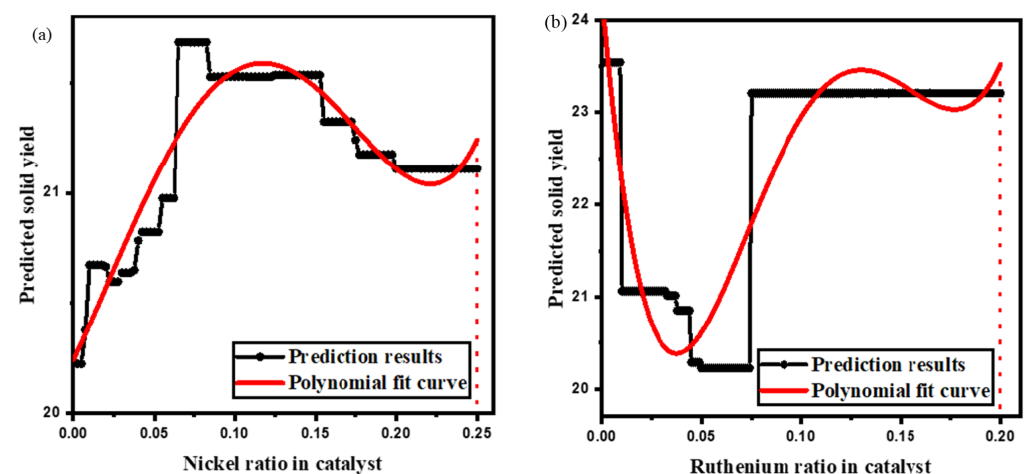
Figure 8. Predicted solid yield of designed lignin-to-solvent ratio (a) and average pore size (b).